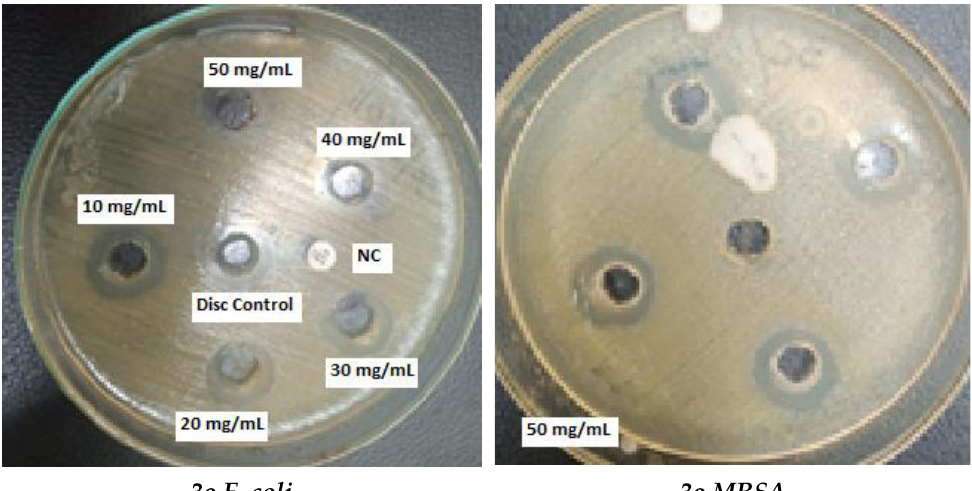
Figure 3. Antibacterial activity of 3e against MDR pathogens. Table 4. ( a ): MIC (mg/mL) and MBC of different compounds against ESBL producing E. coli. ( b ): MIC (mg/mL) and MBC of different compounds against MRSA. (a) Compound No.